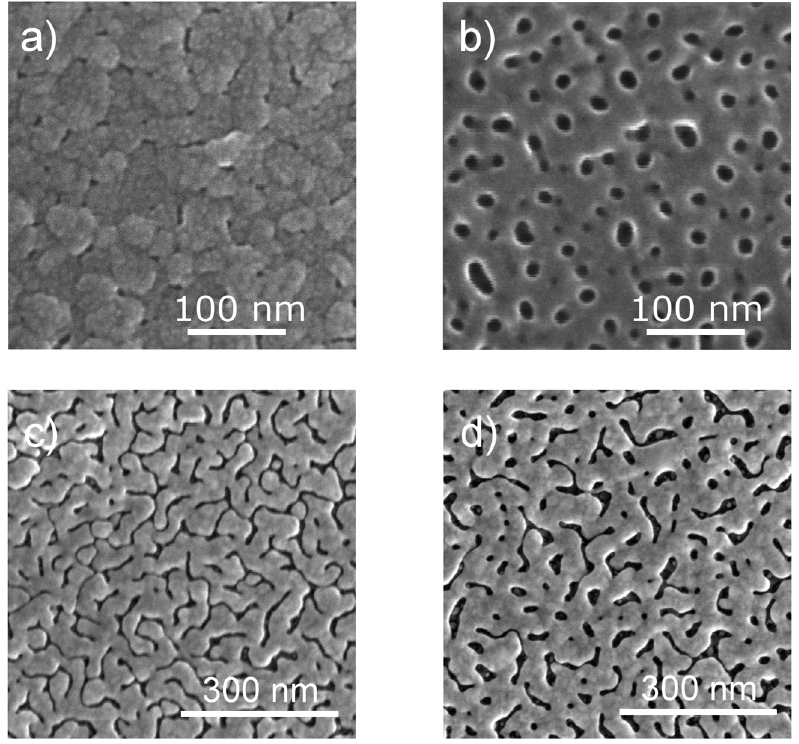
Figure 2. Scanning electron microscopy (SEM) images acquired on utAPA anodized at 20 V in sulfuric acid. Images were taken on the sample ( a ) as-anodized and ( b ) after pore opening. Panels ( c ) and ( d ) show the resulting morphology of the same samples after coating with a 20 and 25-nm-thick gold (Au) layer, respectively.